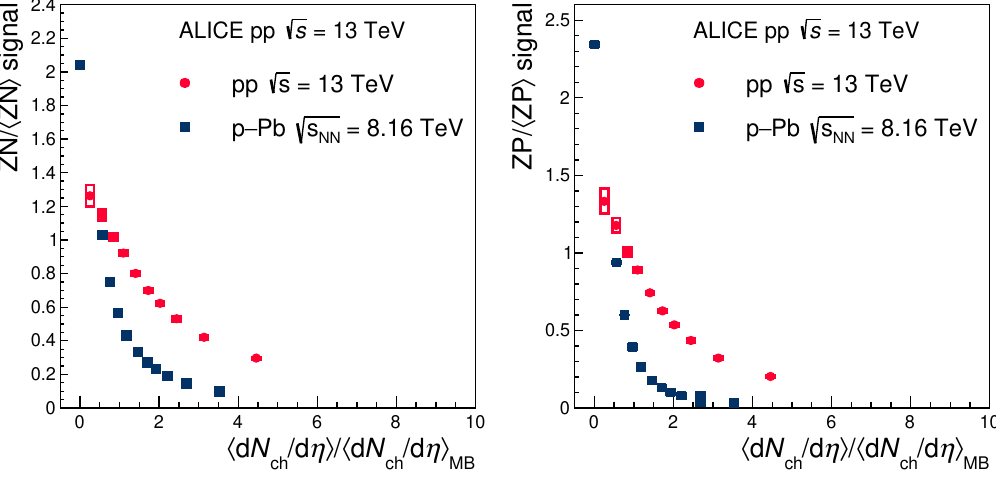
Figure 5 . ZN (left) and ZP (right) self-normalised signals as a function of the normalised multiplicity measured in 2 units of η around the centre-of-mass midrapidity in pp (red circles) collisions and in the p-fragmentation region in p-Pb (blue squares) collisions. The boxes represent systematic